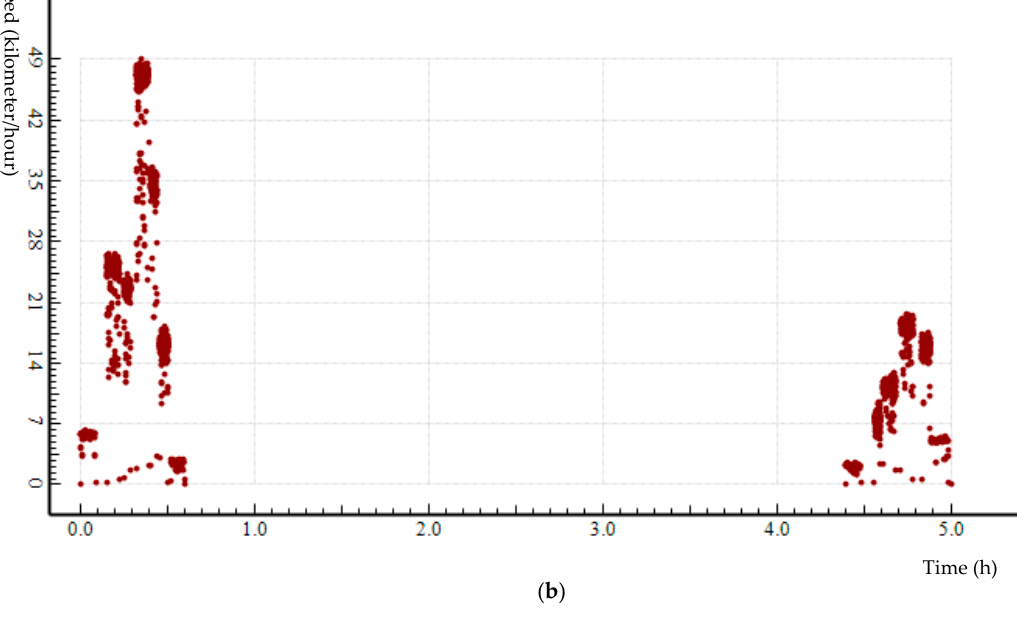
Figure 7. Speed–time graph for: Trajectory 1 ( a ); and Trajectory 2 ( b ).